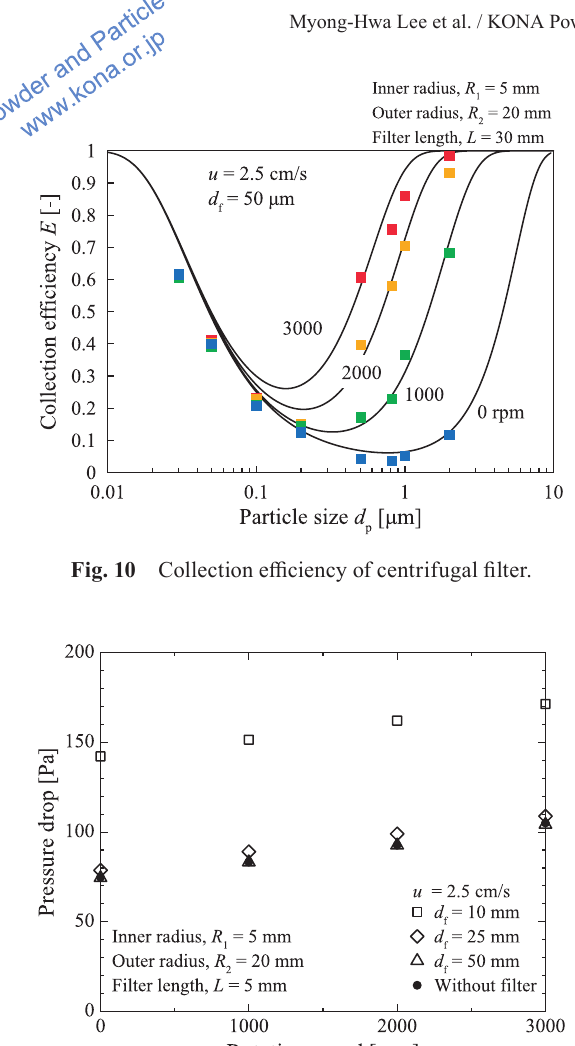
figure, the collection efficiency without rotation (blue squares) is smaller than 10 % at the MPPS (most penetrat- ing particle size) which is about 1 μm. The collection effi - ciency of particles larger than 0.5 μm is significantly improved by rotating the filter. At the maximum rotation speed of 3,000 rpm, the collection efficiency of 1 μm PSL particles increases to 90 %.